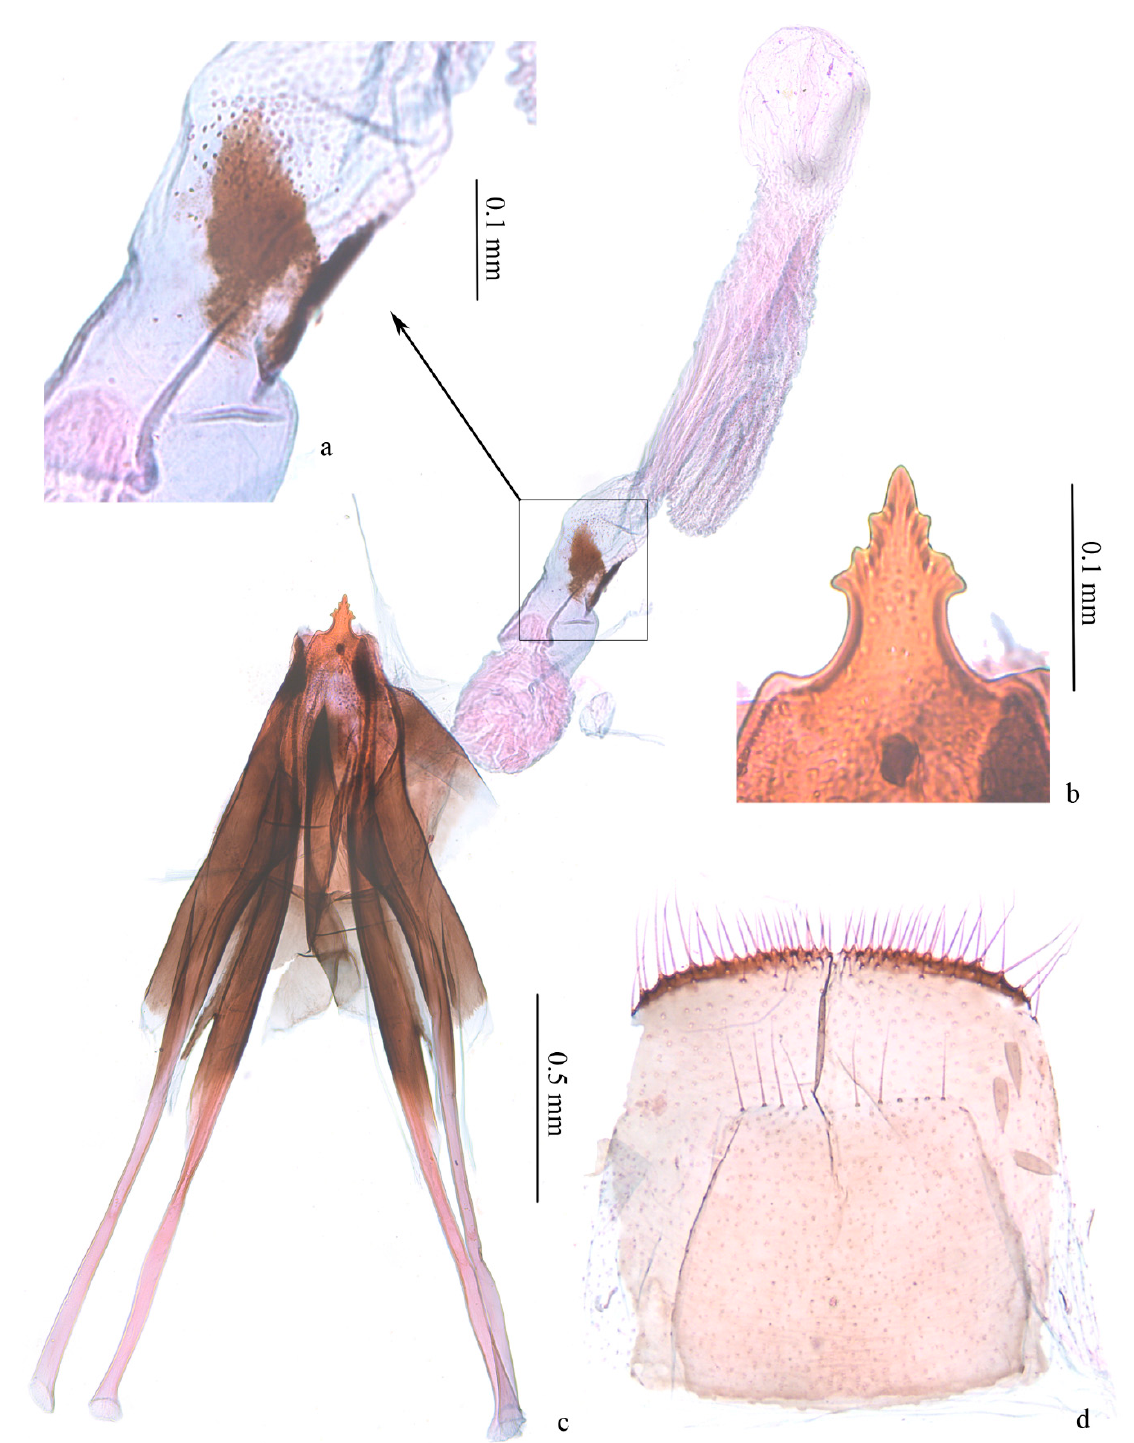
Figure 4. Female genitalia of Subclemensia taigae . ( a ) Triangular sclerotized zones on vestibulum, LIU0283, SDNU.Ent023848; ( b ) ovipositor, same slide as ( a ); ( c ) whole view of female genitalia, same slide as ( a ); ( d ) sternite and tergite of eighth abdominal segment, same slide as ( a ). DNA Barcodes . Three barcodes were generated from larval specimens, process IDs: INCUR001-22, INCUR002-22, INCUR003-22 (Table 1). The genetic analysis also supports the separation of the new species from other related species (Figure